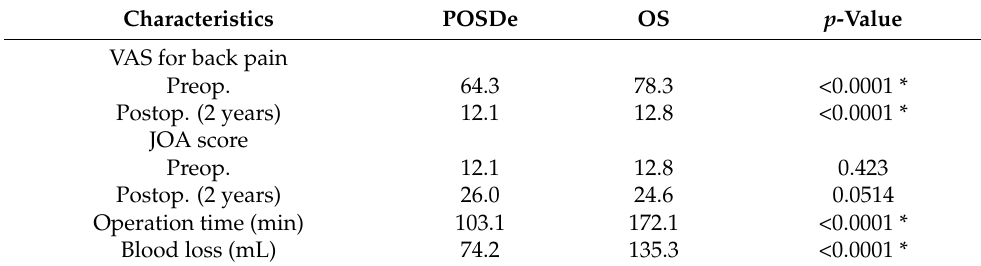
Table 2. Clinical outcomes.